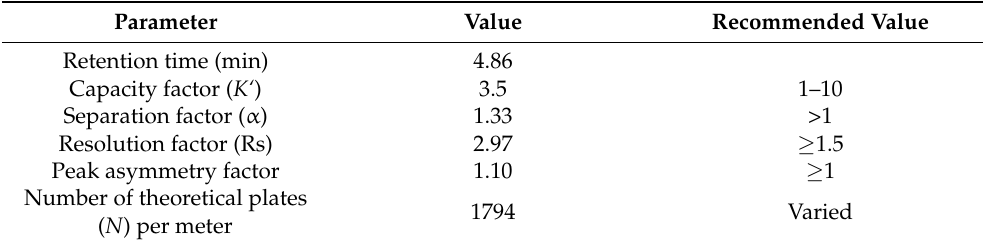
Table 2. Chromatographic parameters for ALC by the proposed HPLC-FD